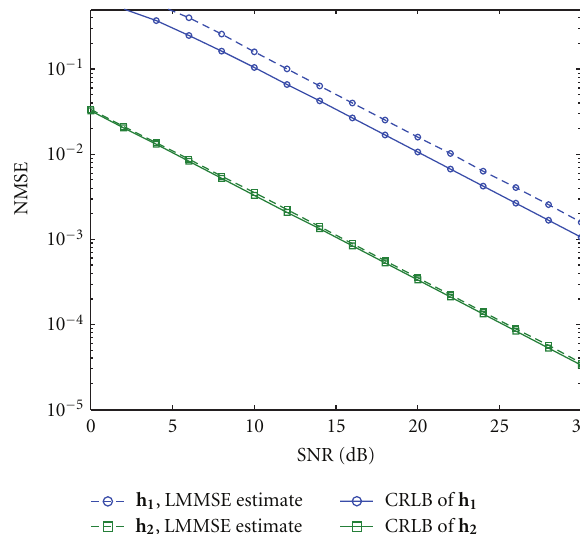
Figure 4: Channel estimation NMSEs versus SNR for α = 0.25.